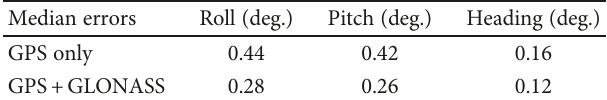
Table 3: GNSS attitude performance — median RMS error. Median errors